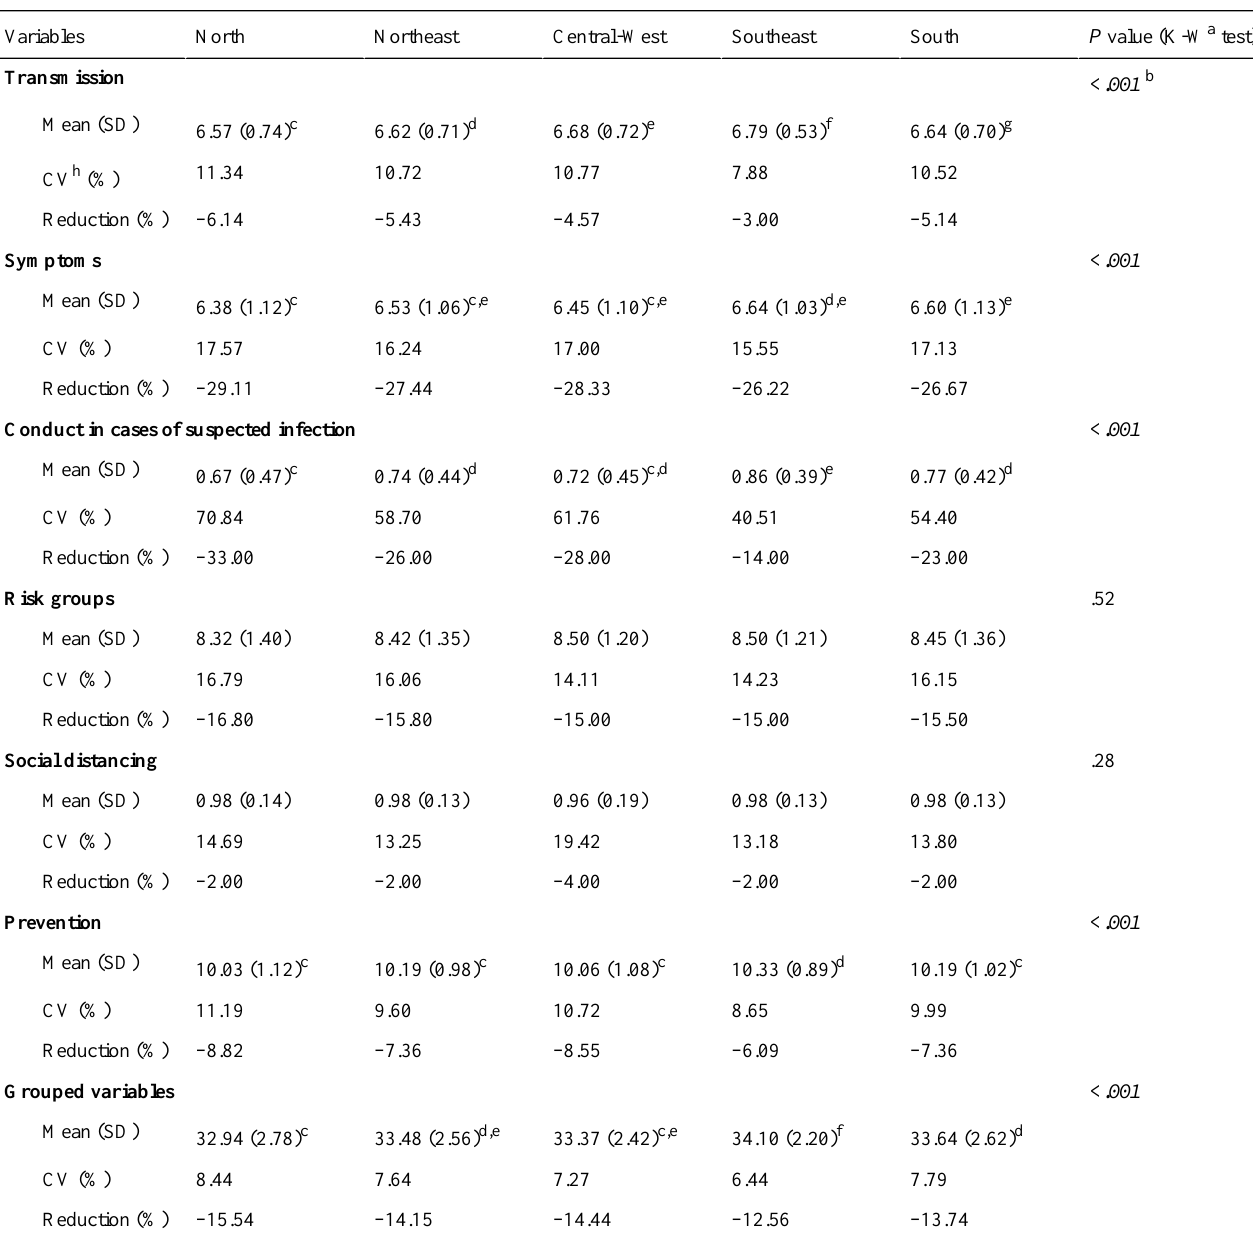
Table 4. Sample statistical analysis based in geopolitical regions.